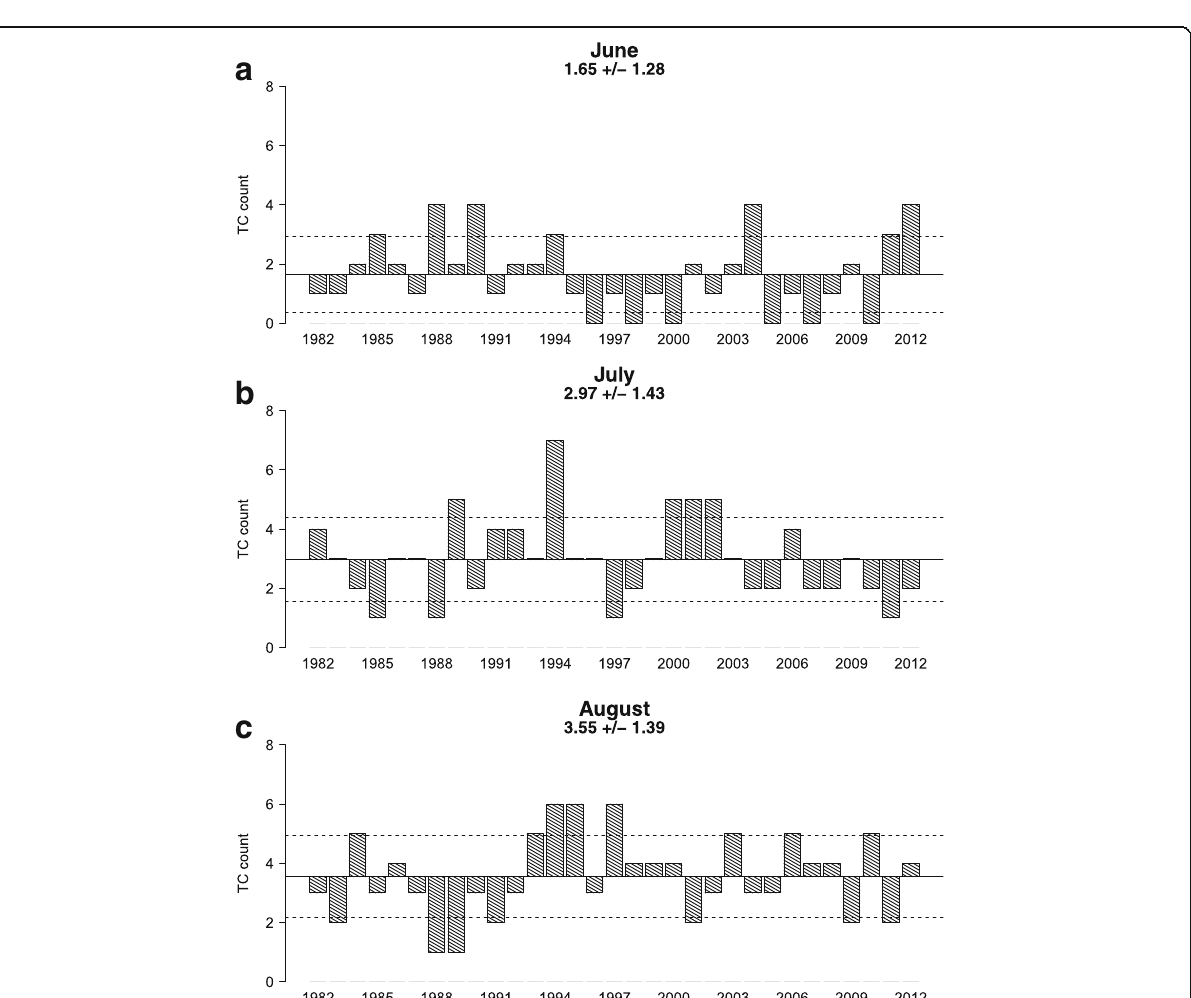
Fig. 11 Number of tropical cyclones passing through domain 1 (D01 in Fig. 1) for each month ( a – c ) from 1982 to 2012 based on JTWC best track data. The counts are plotted around the mean, while the dashed lines indicate the standard deviation. The means and standard deviations are written in the graph for each month